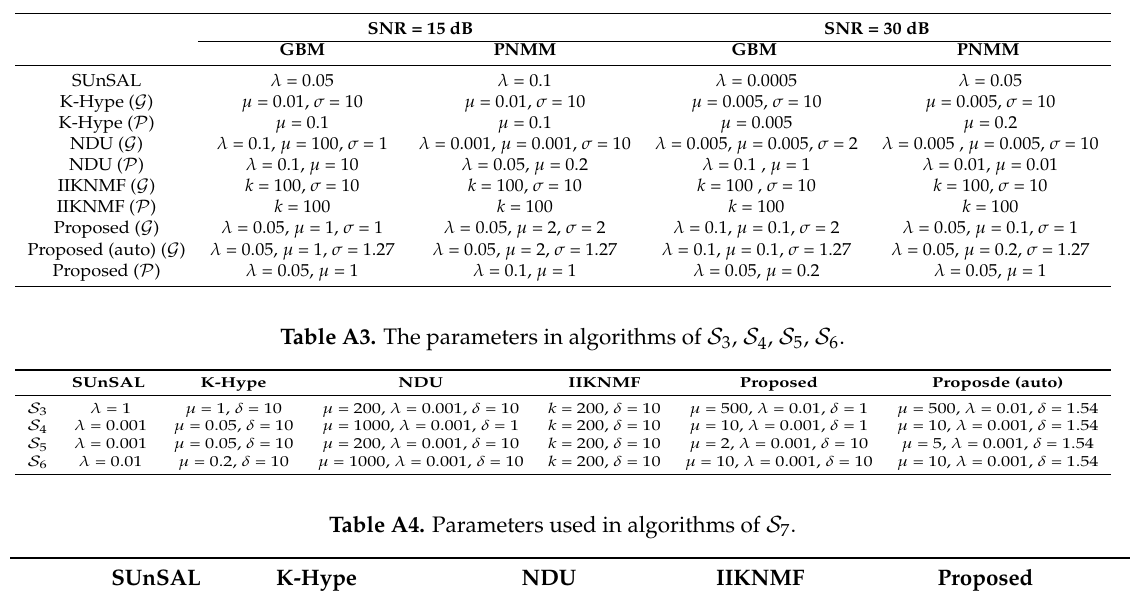
Table A2. The selected algorithm parameters for S 2 .